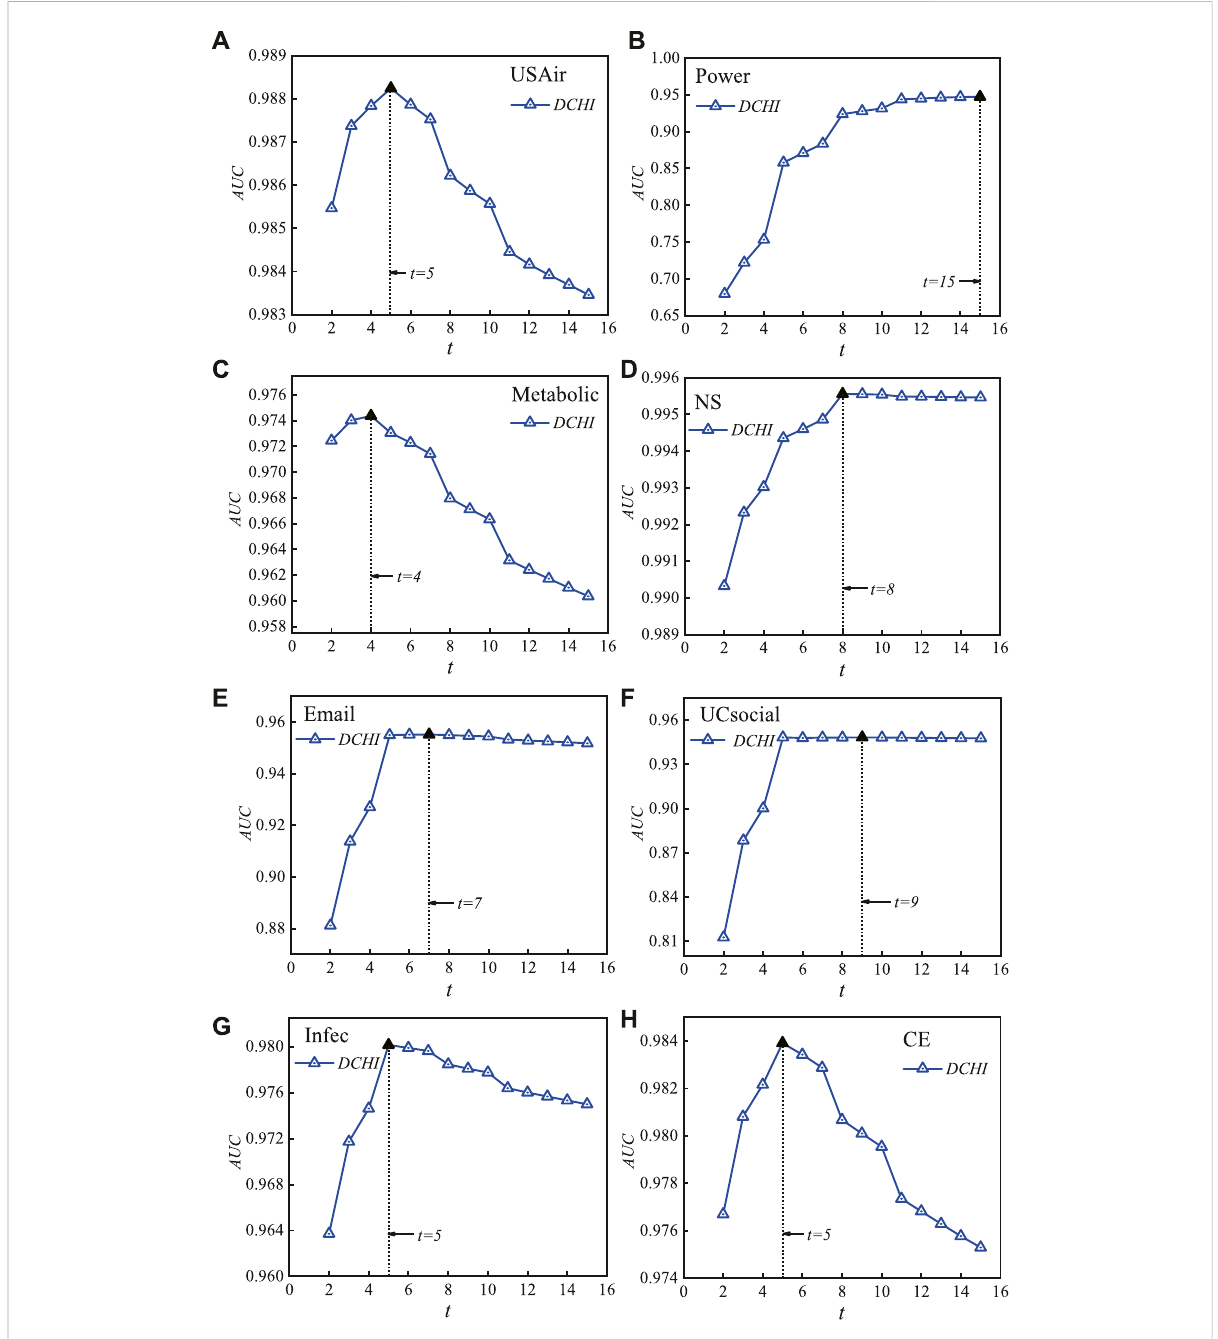
FIGURE 2 (ColorOnline)PatternillustrationofaccuracymetricAUConthenumberofrandom-walksteps t oneightdatasets.Withthefeweststeps,DCHI achievesthemostidealAUCvalues,whichis5in (A) USAir,15in (B) power,4in (C) Metabolic,8in (D) NS,7in (E) email,9in (F) UCsocial,5in (G) Infec, and 5 in (H)